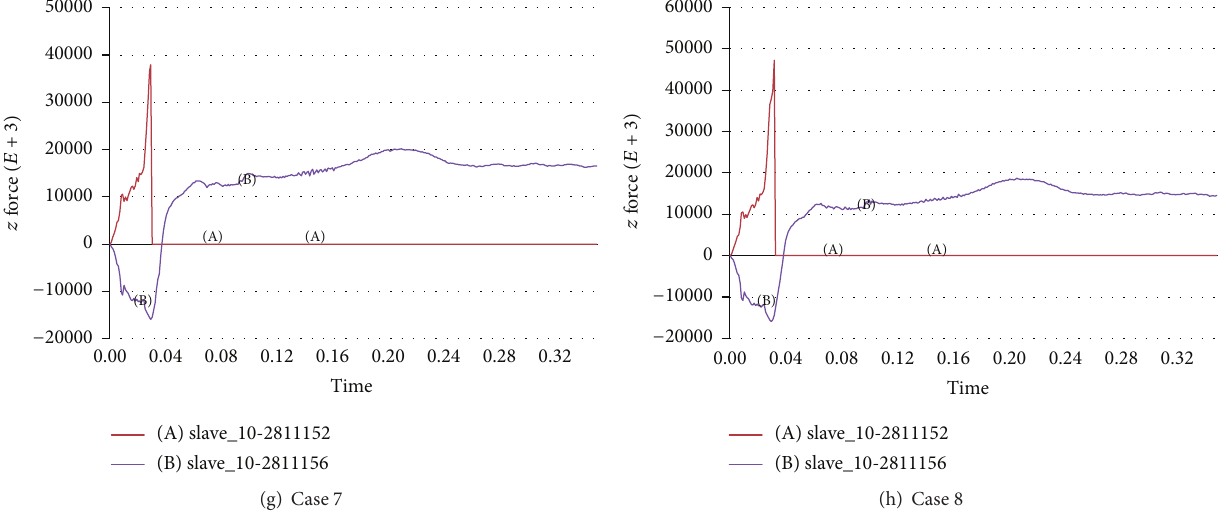
Table 1: Analysis cases by different breakaway conditions ( 𝑓 𝑡